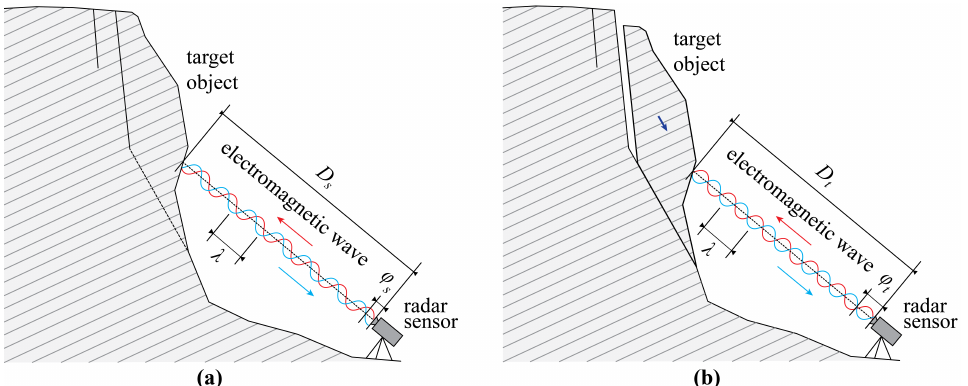
Figure 5. Measurement principle of radar interferometry for a FMCW radar sensor with ( a ) showing the situation before and ( b ) the situation after the displacement of the